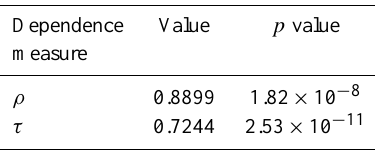
Table 1. Location parameter ( µ ) and scale parameter ( γ ) of Gumbel distributions for the variables of peak ( Q ) and volume ( V ).